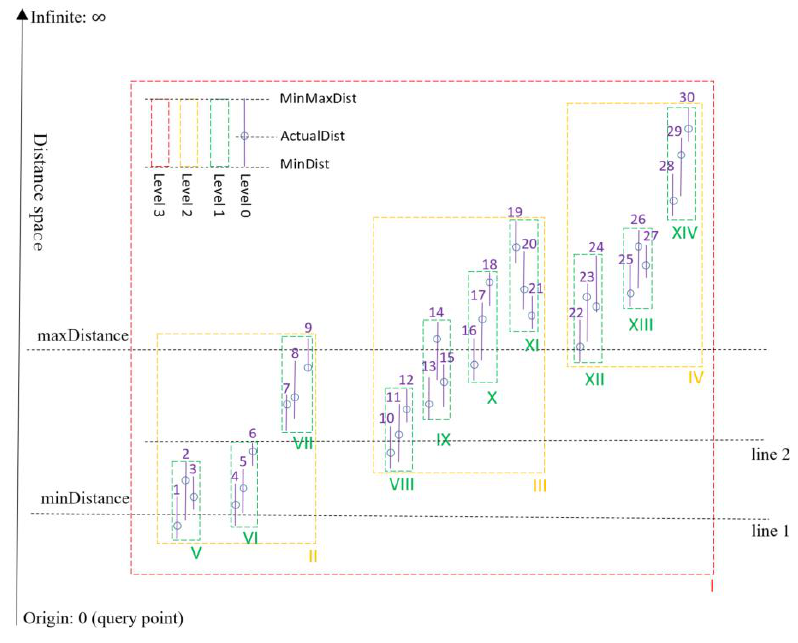
Figure 8. The distance distribution graph of an R-tree with respect to a query point.